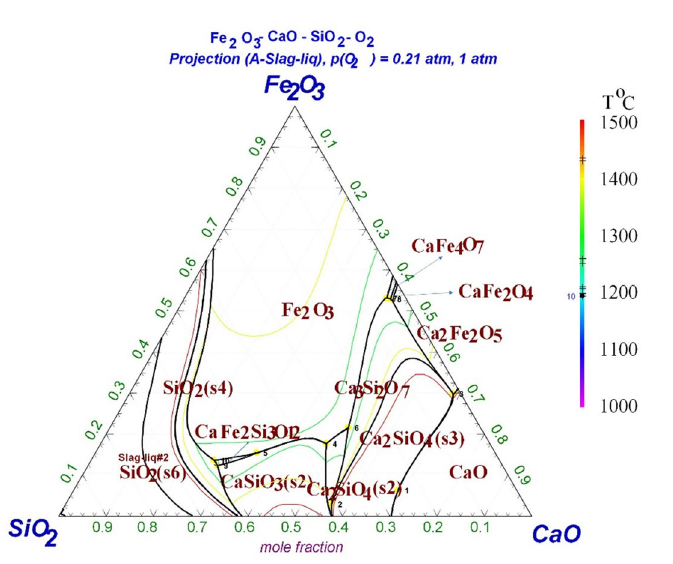
Figure 8. Fe 2 O 3 –SiO 2 –CaO phase